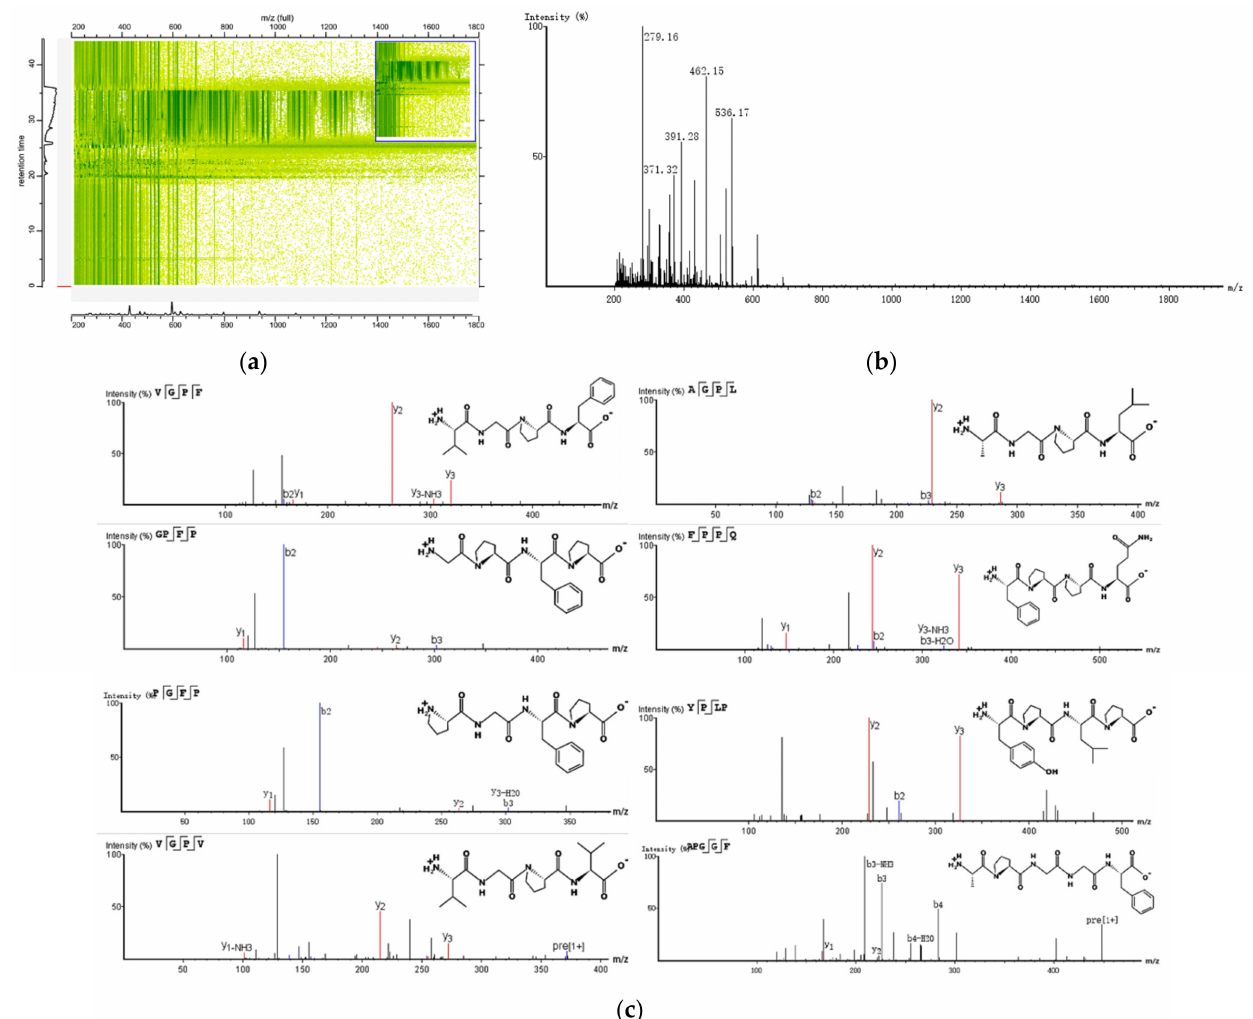
Figure 4. Identification of the molecular mass and amino acid sequence of the AP-D10 peptide using the UHPLC-LTQ-Orbitrap mass spectrometer. ( a ) Total ion chromatography of AP-D10. The ionic intensity is shown in green. ( b ) Mass spectrum of AP-D10. ( c ) Identification of amino acid sequence by MS/MS spectrum and the structure of the